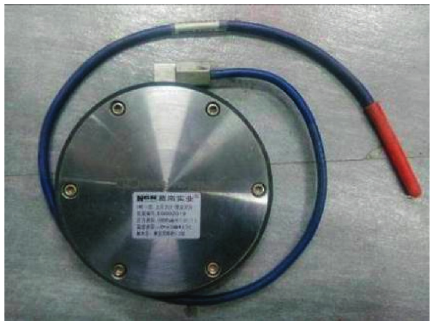
Figure 12: The soil pressure cell.